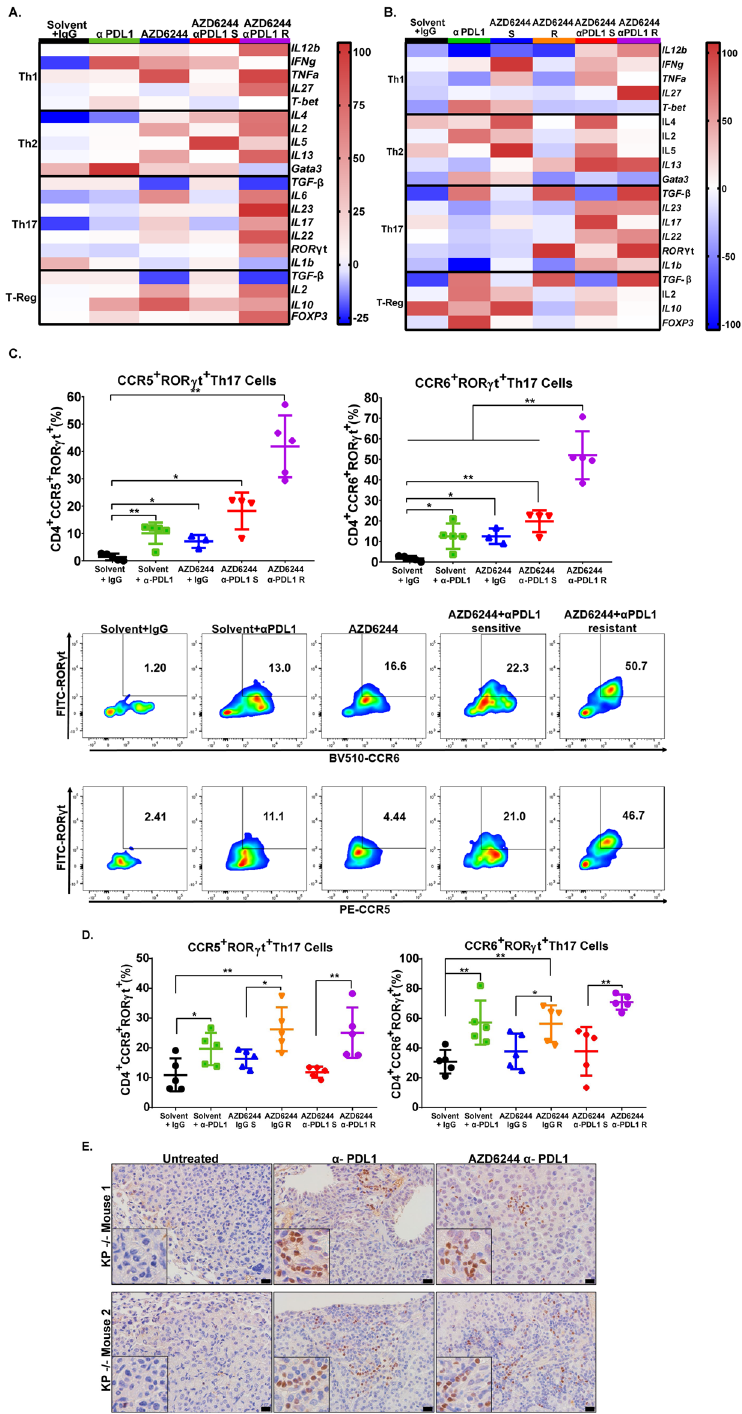
Fig. 3 Combination therapy-resistant tumors have increased levels of Th17 CD4 + T cells. A Cytokine qPCR array heatmap of 344SQ tumors from the experiment in Fig. 2A. Solvent + IgG (black), 25 mg/kg AZD6244 (blue) or weekly treatment with 200 µ g PD-L1 blocking antibody (green) as single- agents or in combination sensitive group denoted by (S) (red), combination resistant group denoted by (R) (purple). B Cytokine qPCR array heatmap of 393P tumors from the experiment in Fig. 2D. C Top: percent of CCR5 + ROR γ t + and CCR6 + ROR γ t + Th17 CD4 + T cells in 344SQ tumors from treatment experiment in Fig. 2A. All populations gated from total CD4 + T cells in Supplementary Fig. S3D. Bottom: representative dot plot for CCR5 + ROR γ t + and CCR6 + ROR γ t + Th17 CD4 + T cells. Data are presented as mean values ± SD. N = 3 – 5 mice per group. Data were analyzed using unpaired Students ’ t test. * P < 0.05; ** P < 0.01. D Percent of CCR5 + ROR γ t + and CCR6 + ROR γ t + Th17 CD4 + T cells in 393P tumors from treatment experiment in Fig. 2D. Data are presented as mean values± SD. N = 3 – 5 mice per group. Data were analyzed using unpaired Students ’ t test. * P < 0.05; ** P < 0.01. E ROR γ t IHC stains of KP mice lung tumors treated weekly with 200 µ g of PD-L1-blocking antibody alone or in combination with 25 mg/kg daily treatments of AZD6244 for 17 weeks from the experiment in Fig. 2G. Scale bar = 50 µ m.